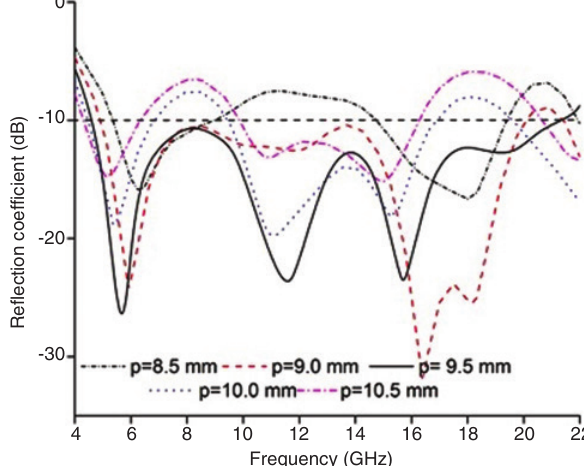
Figure 7: Reflection coefficient for different values of substrate height.